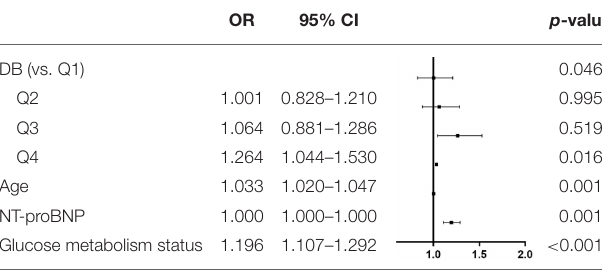
TABLE 3 | Multivariate logistic analysis for intermediate–high